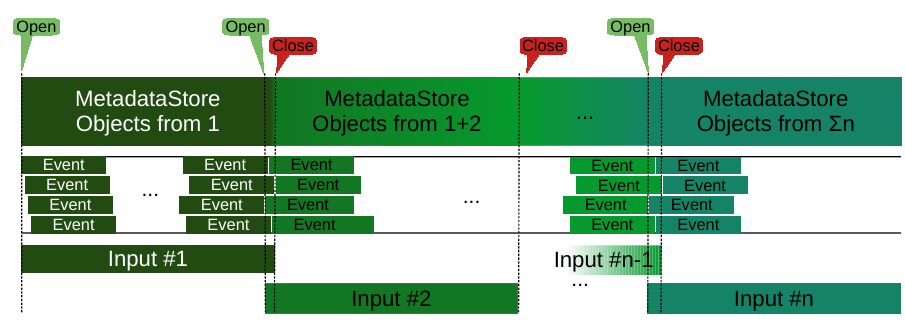
Figure 1. A multi-threaded job processes a number of events concurrently. The job reads events from many input files and writes results to one output file. The second input file is opened when no further events from the first input file remain to be processed, and so on. An input file is closed after the job finishes processing the last event from that file because ATLAS reads persistent data on demand. That means, the job processes the initial events from the new input file concurrently with events from